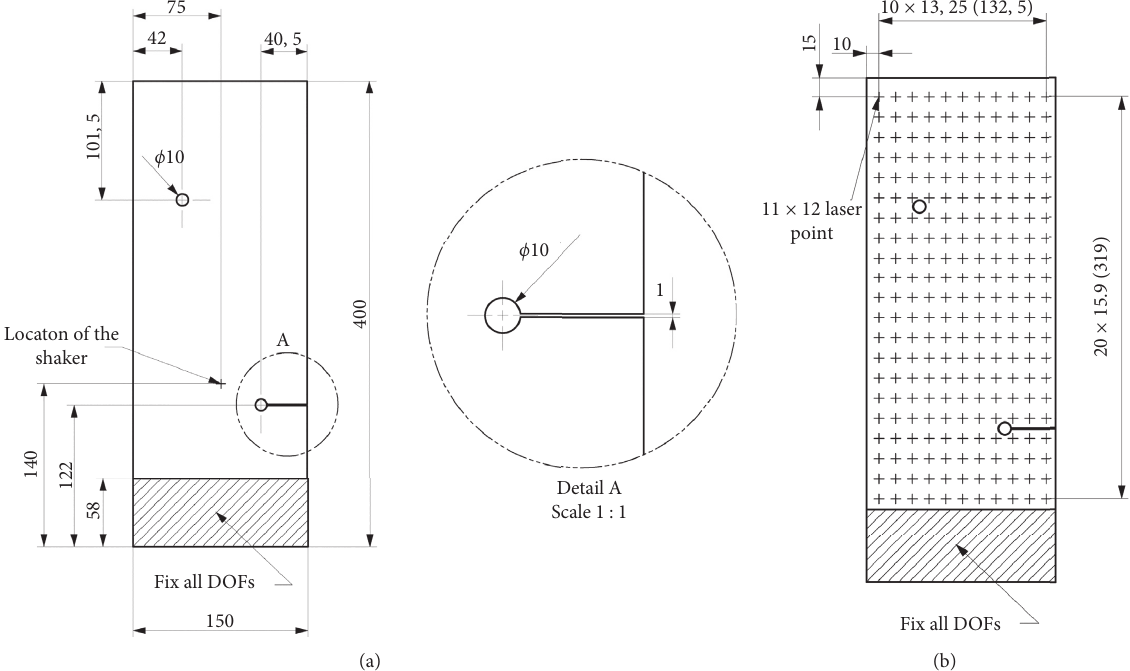
Figure 4: (a) Plate dimensions and damage locations. (b) Points for which data were